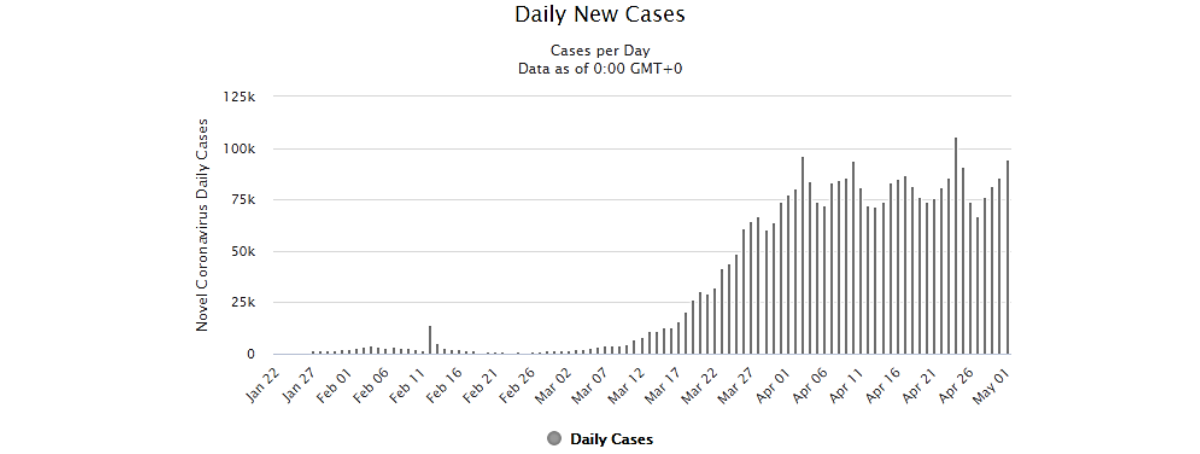
Figure 1. General overview of all reported cases of COVID-19 worldwide from February to May 2020. Source: Worldometer [61].